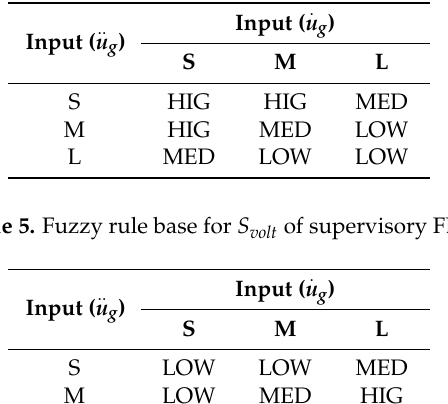
Table 4. Fuzzy rule base for N d and N v of supervisory FLC.